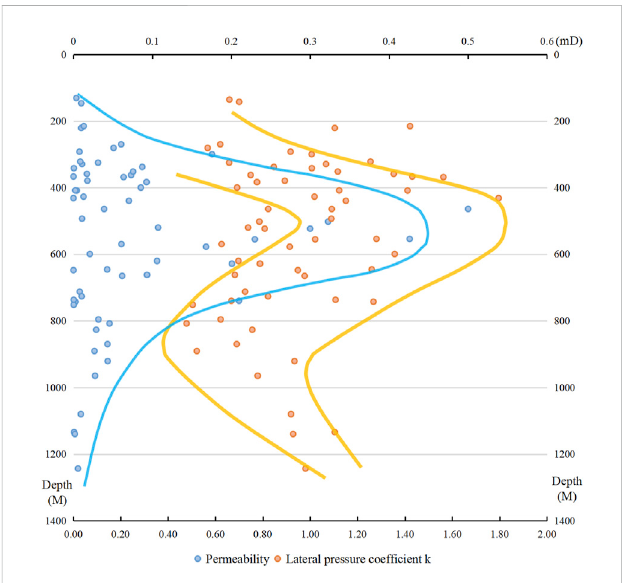
Relationship between lateral pressure coef fi cient and permeability with depth (the light blue line corresponds to the envelope of permeability, the yellow line corresponds to the trend of lateral pressure coef fi cient, depicting its upper and lower